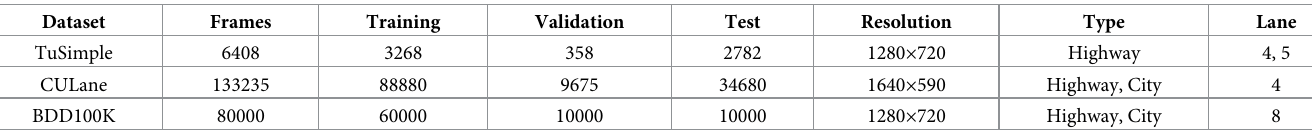
Table 1. Information about datasets. Dataset